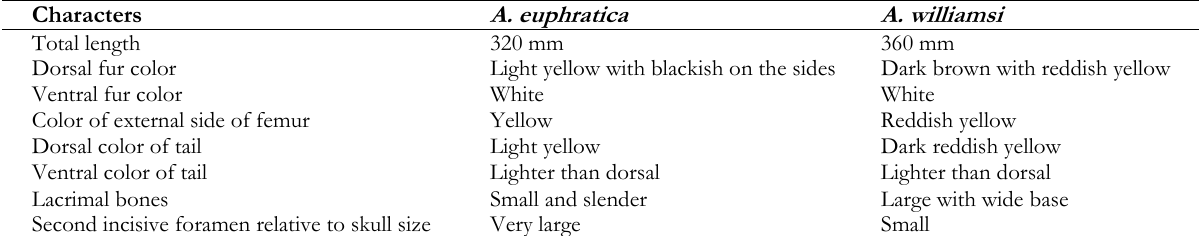
F IGURE 3. Dendrogram based on Euclidean distance of morphometric variables. T ABLE 1. Morphological characters of A. euphratica from Ilam and A . williamsi from western